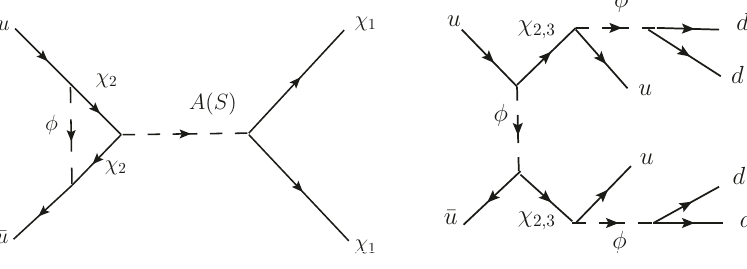
Figure 9 . Diagrams showing dominant contributions to χ 1 , χ 2 and χ 3 production at the